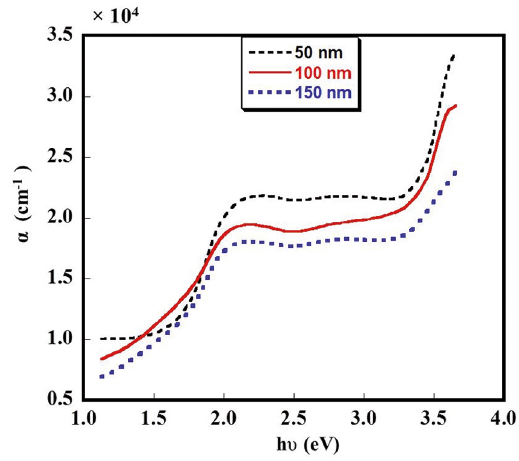
Figure 7: Absorption coefficient (α) as a function of photon energy (hυ) of V: In O films with different thicknesses. 2 3